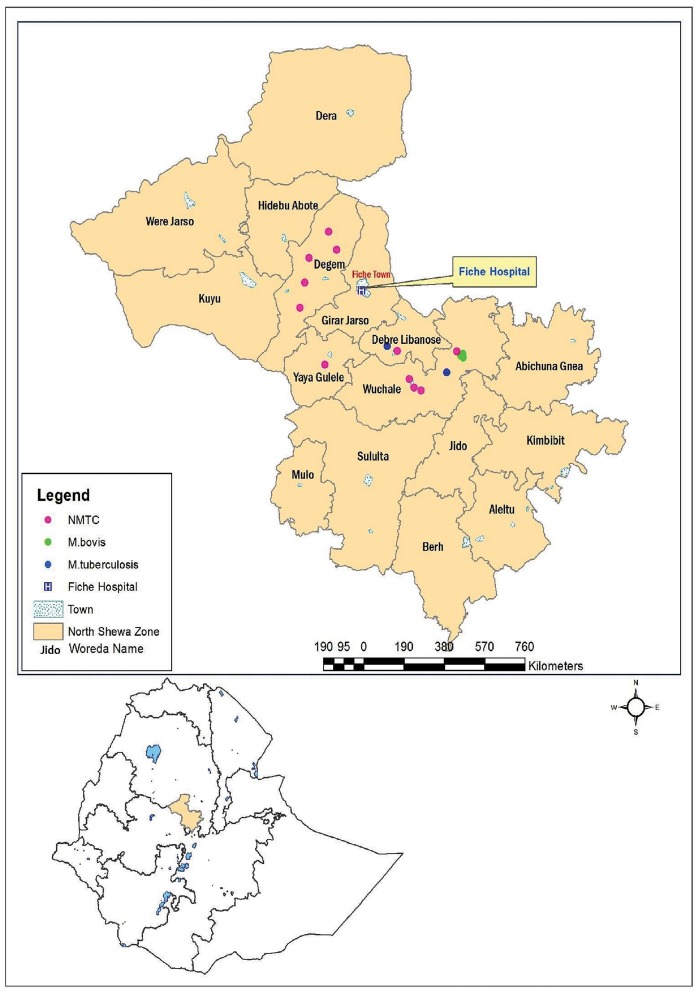
Distribution and frequencies of mycobacteria isolated from tissues of skin test positive cattle in central Ethiopia.Majority (68.8%) of the isolates were NTMs (pink dots on the map) while 18.8% were M. bovis (green dots) and 12.6% were M. tuberculosis (blue dots).